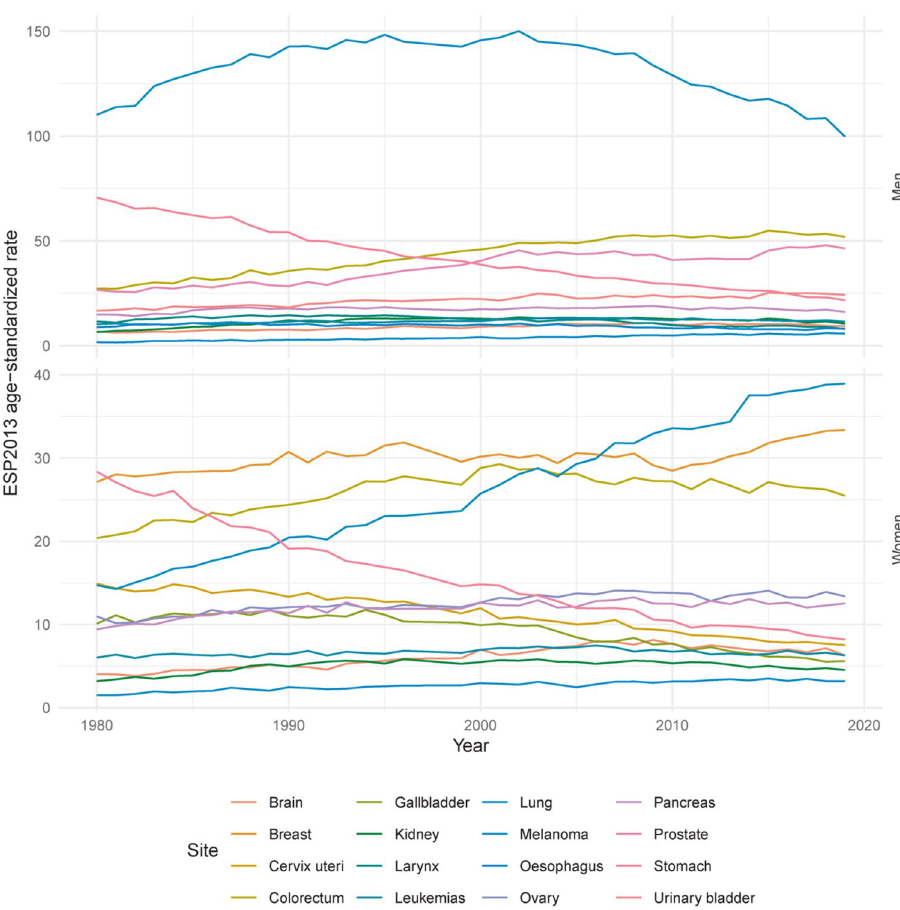
Figure 4. Age-standardized (ESP2013) mortality rates per 100,000 for the most common cancer sites, by sex— Poland,